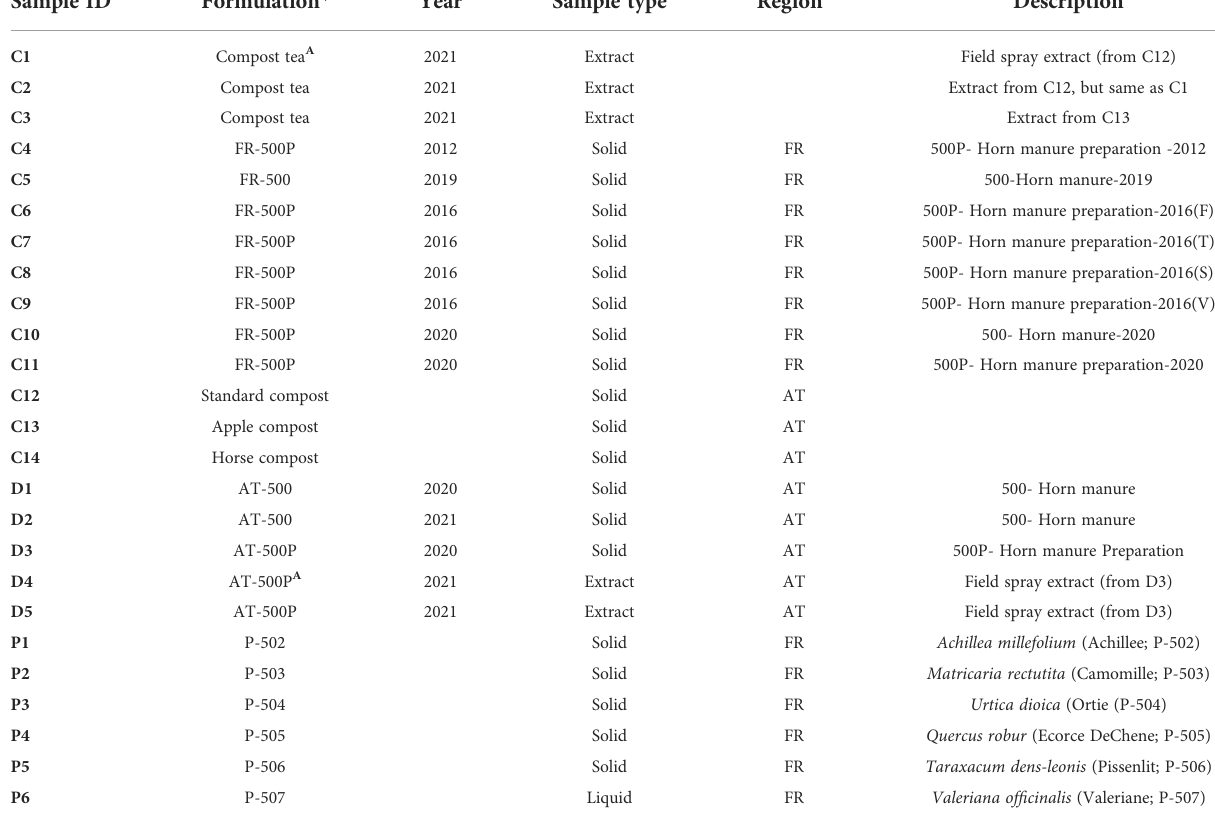
TABLE 1 Overview of the studied composts (i.e., apple-, horse-, and standard compost) and biodynamic manures (with/without plant preparations). Sample